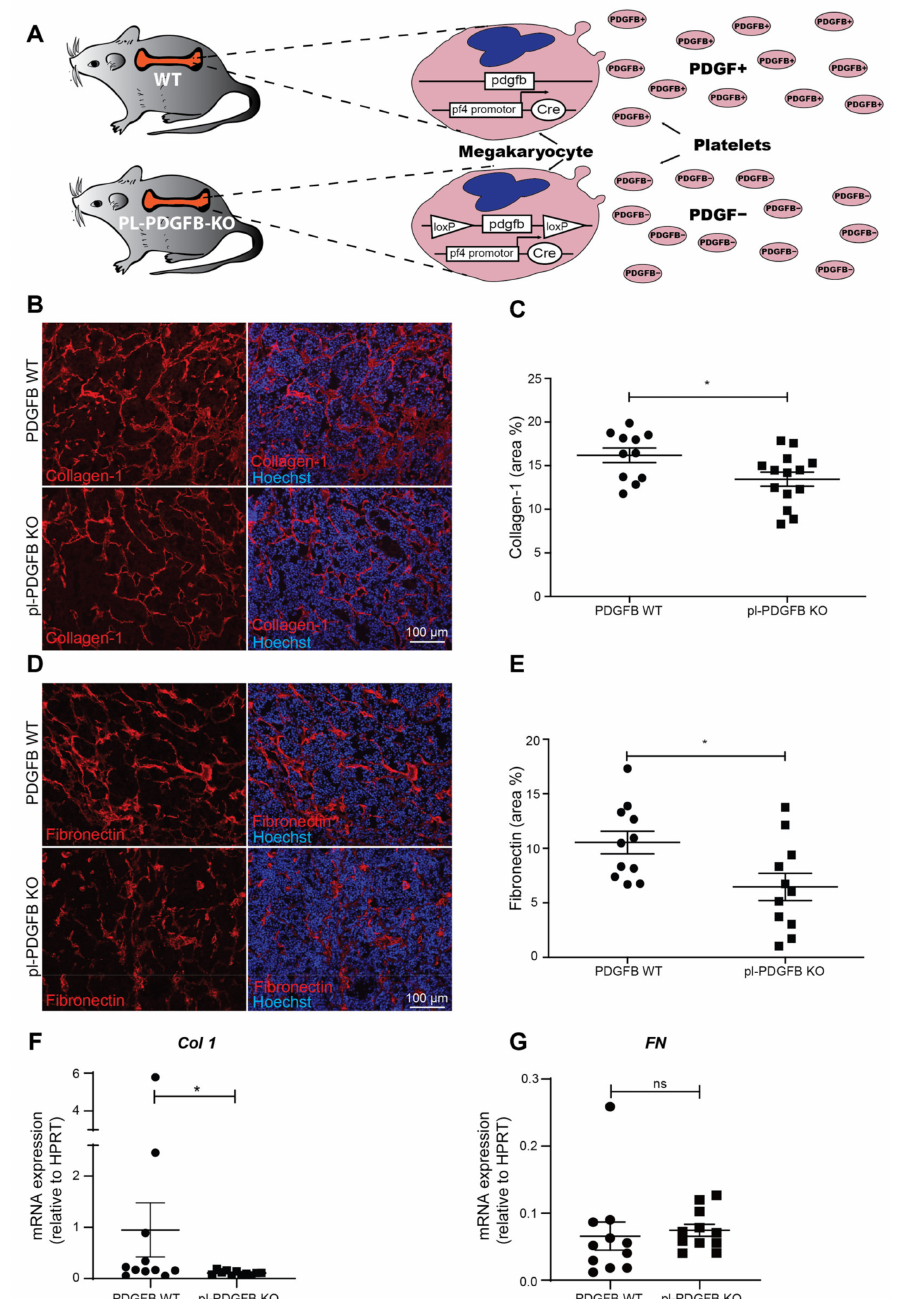
Figure 1. Reduced ECM deposition in tumors from mice lacking PDGFB in platelets. ( A ) Mice lacking PDGFB in the platelet/megakaryocyte lineage were generated using the Cre-loxP recombination system, with Cre expressed under the PF4 promoter. ( B – E ) Sections of tumor tissue from 14-week old WT and pl-PDGFB KO RT2-positive mice were immunostained for ( B , C ) collagen 1 (WT n = 11; KO n = 14, * p = 0.0280) and ( D , E ) fibronectin (WT n = 11; KO n = 11, * p = 0.0207) and the positive areas quantified using Image J. Expression of collagen 1 (Col1;WT n = 11; KO n = 11, * p = 0.0336) ( F ) and fibronectin (FN; WT n = 11; KO n = 11, * p = 0.1464) ( G ) were analyzed by qPCR in tumors from 14-week old WT and pl-PDGFB KO RT2-positive mice. Error bars in the graphs represent the standard error of mean